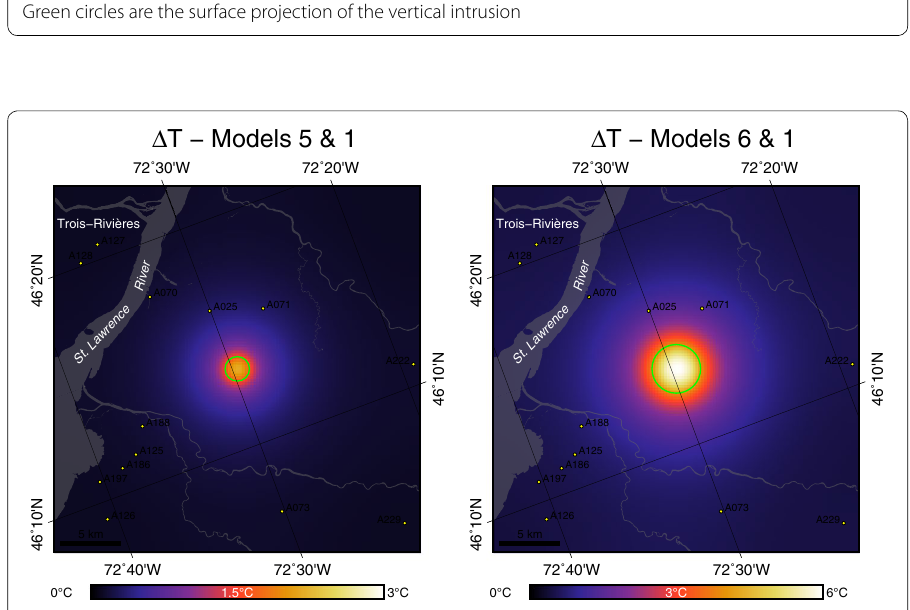
Fig. 10 Temperature difference between Models 5–6 and Model 1. Temperature difference between Models 5–6 and Model 1 at 5 km depth. Green circles are projection of the